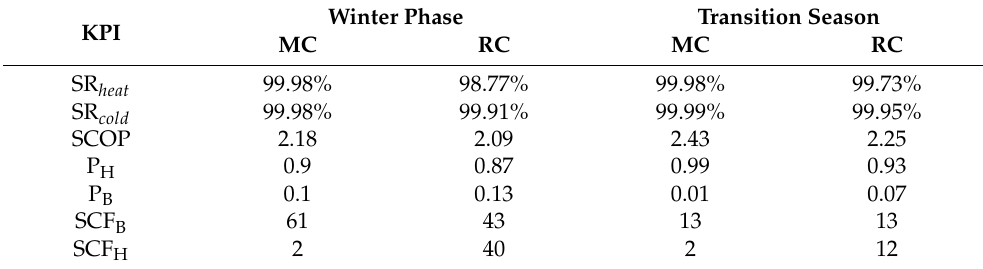
Table 5. The KPIs of the energy system are respectively controlled by the tuned mode-based control strategy (MC) and the reference control (RC). SR: satisfactory rate; SCOP: seasonal coefficient of performance; P: part of energy supply; SCF: signal-changing frequency; B: boiler; H: heat